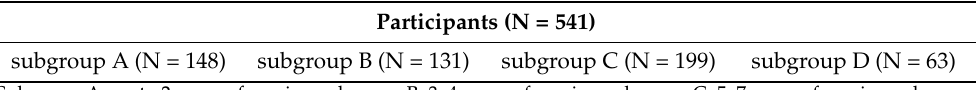
Table 1. The group size of the Polish ECDs subgroups separated by the number of years of work.